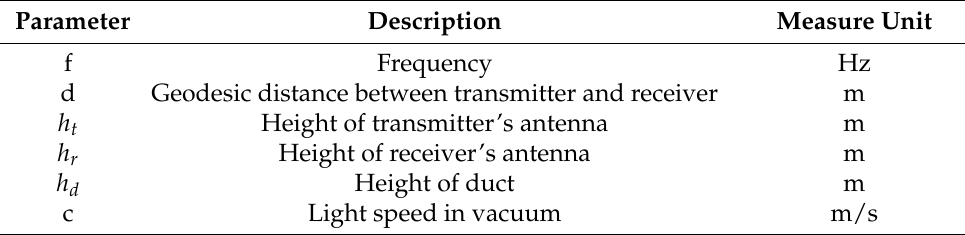
Table 4. Parameters involved in Equations (7)–(10): description and measure units.